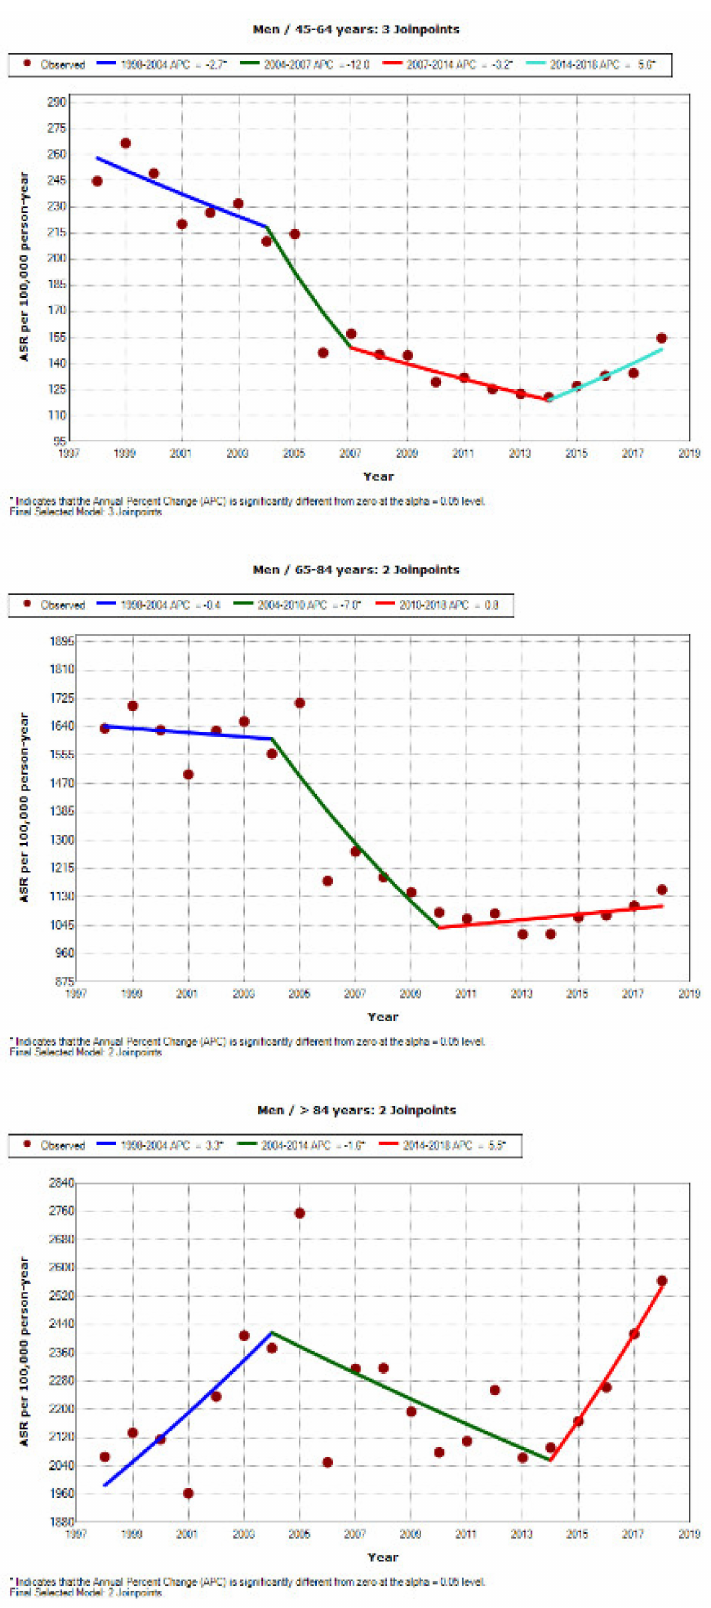
Figure 2. Joinpoint regression analysis of trends in hospital admission due to COPD in men Spain from 1998 to 2018, by age